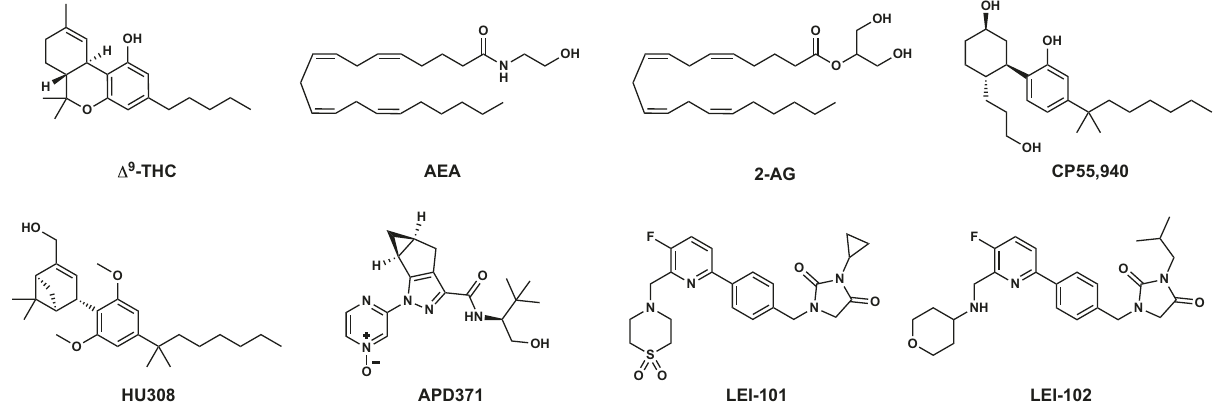
Fig.1|Chemicalstructures. ShownarethemainconstituentofCannabissativa Δ 9 -tetrahydrocannabinol(THC),andthetwomajorendocannabinoidsanandamide(AEA) and 2-arachidonoylglycerol (2-AG), as well as non-selective CBR agonist CP55,940 and CB 2 R agonists HU308, APD371, LEI-101, and